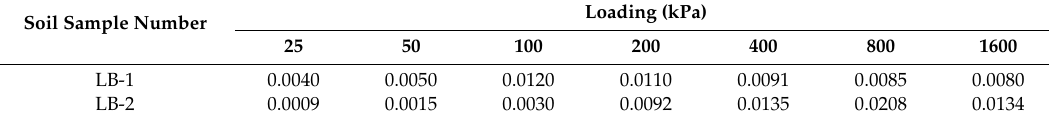
Figure 6. e -log t curves of samples LB-1 and LB-2 under primary loading condition. Table 5. Fitting results of secondary consolidation coefficient C α under primary loading conditions.